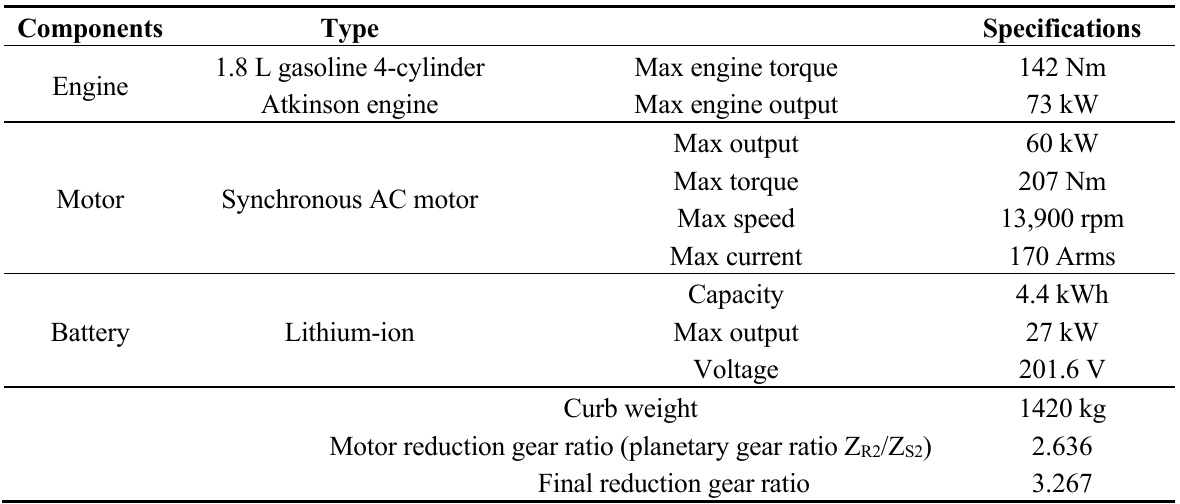
Figure 1. Structure of target plug-in hybrid electric vehicle. C1: Carrier 1; MG: motor/generator. Table 1. Specifications of the target PHEV (plug-in Prius)